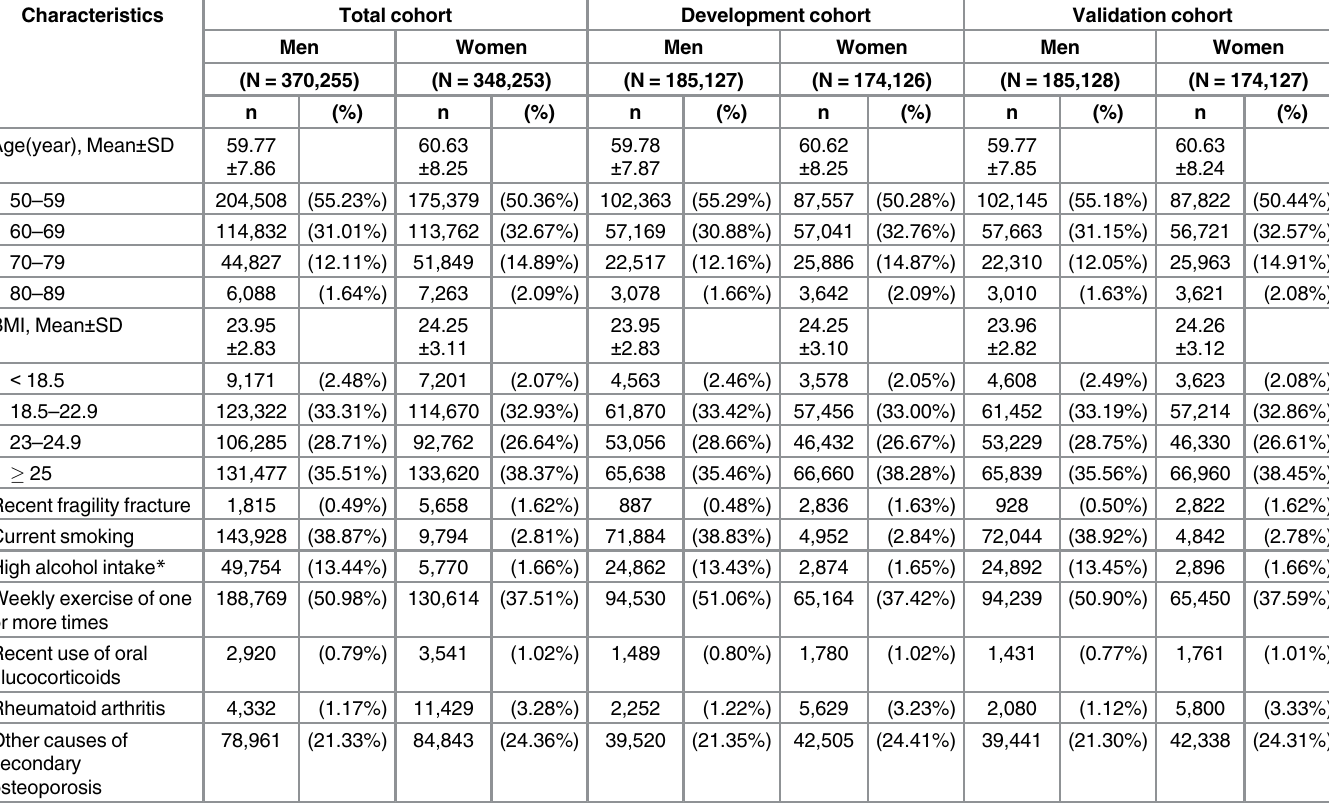
Table 1. Baseline characteristics of the study